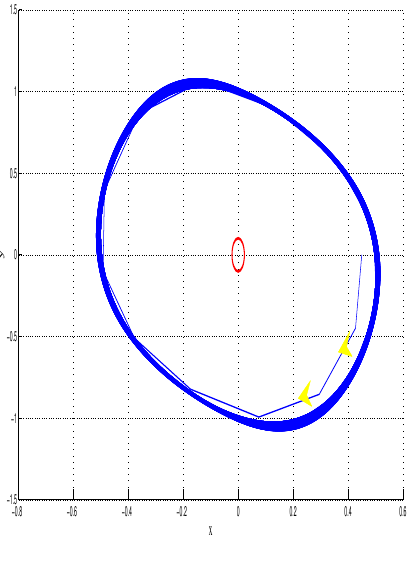
Figure 11. The numerical solutions generated by the RK2 scheme with h = 0 . 7 and t ∈ [0 , 980] in Example 5.